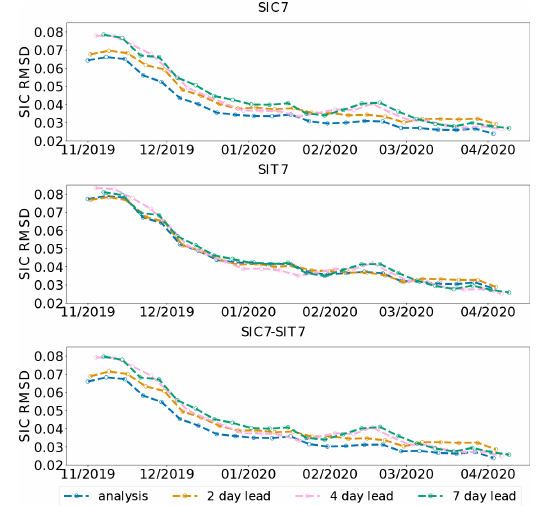
Figure 3. SIC RMSD for 4 weeks of the moving-averaged forecast regarding the assimilation time. Each line represents a different lead